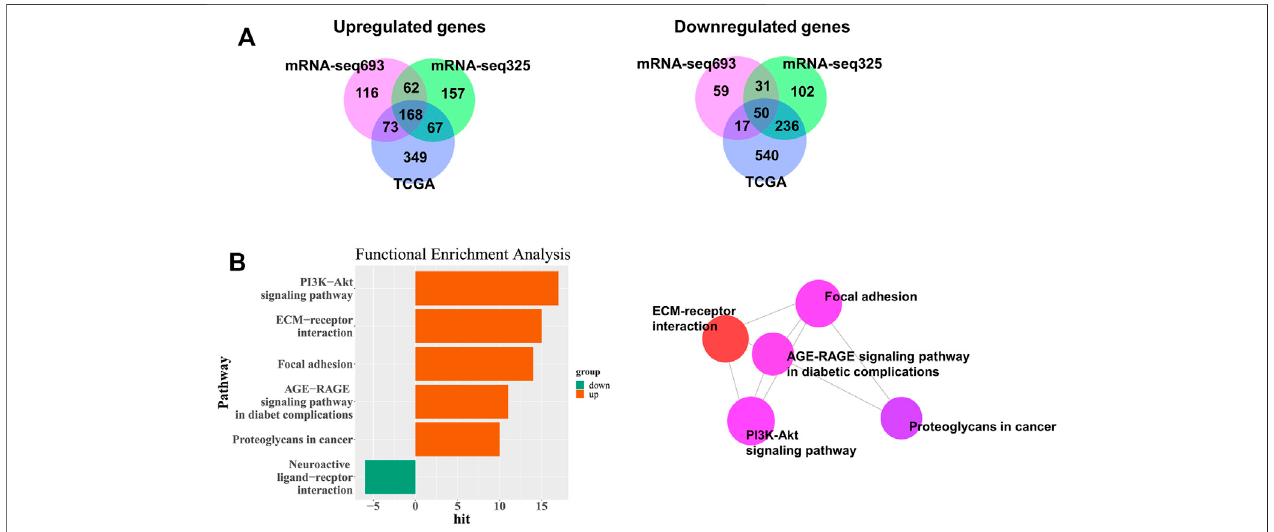
FIGURE 2 | Identi fi cation of DEGs among TCGA and CGGA datasets of GBM and LGG. (A) Venn diagrams of overlapping DEGs among TCGA, CGGA mRNA- seq325 and CGG mRNA-seq693. (B) Signi fi cantly enriched biological process and